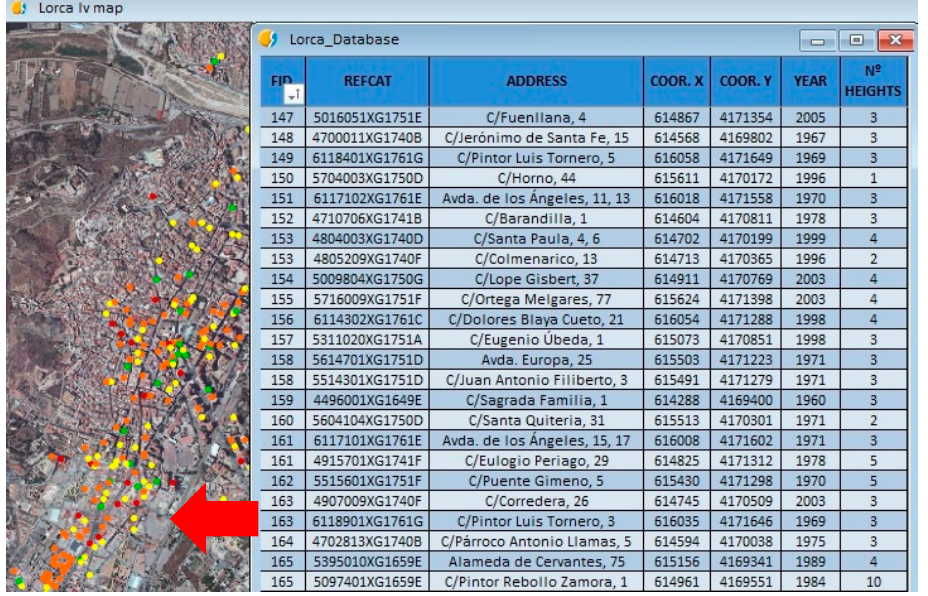
Figure 5. Implementation of cadastral database of reported damage buildings used in this case study.